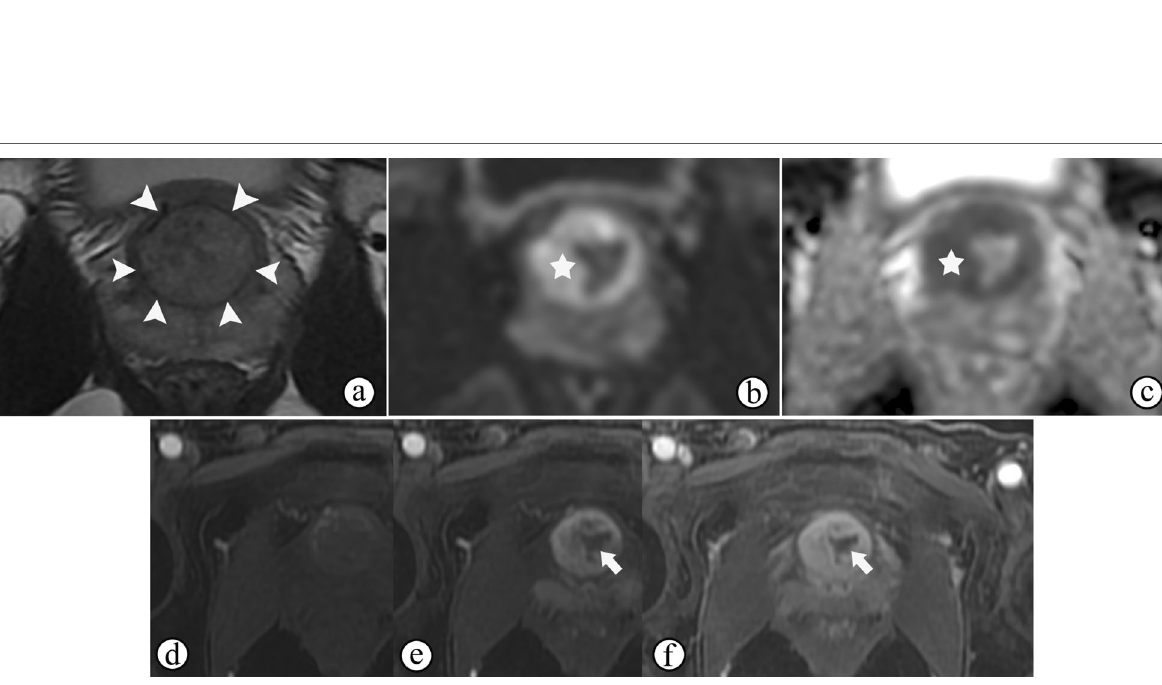
Fig. 13 Prostate stromal tumor of uncertain malignant potential in a 33-year-old man with a normal serum PSA level of 1.080 ng/mL. a Axial T2WI shows a 2.7-cm nodule with heterogeneous signal in the TZ of the prostate surrounded by a capsule-like hypointense rim (arrowhead). b, c DWI and ADC maps show remarkably restricted diffusion of most of the nodule ( ☆ ). d–f Axial DCE imaging at 30 s ( d ), 60 s ( e ) and 120 s ( f ) after contrast injection shows early and gradual enhancement of the nodule containing non-enhanced areas inside the tissue